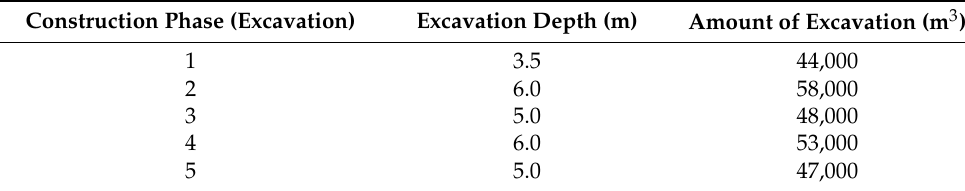
Table 7. Excavation parameters of foundation pit soil.